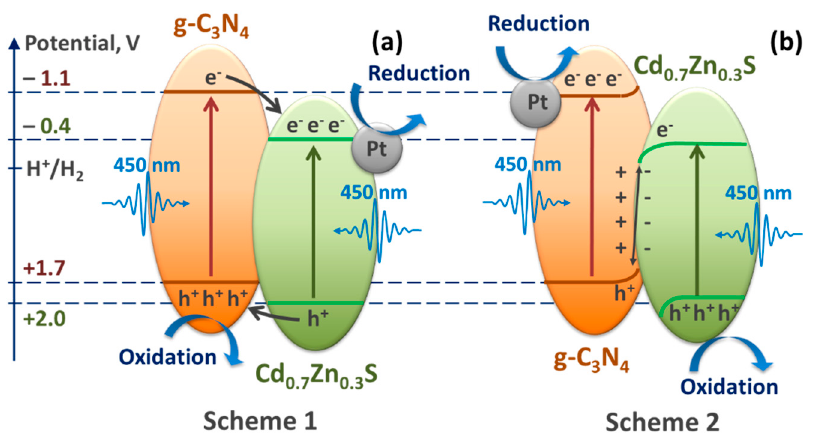
Figure 7. Scheme of heterojunctions for the photocatalysts Pt/20Cd0.8/CN ( a ) and 20Cd0.8/Pt/CN ( b ).